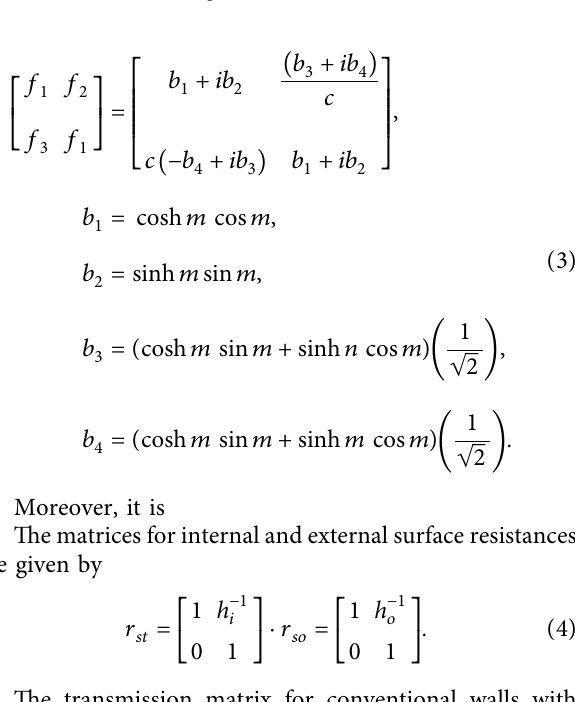
Figure 3: (a) Cube-shaped building model; (b) RCC roof